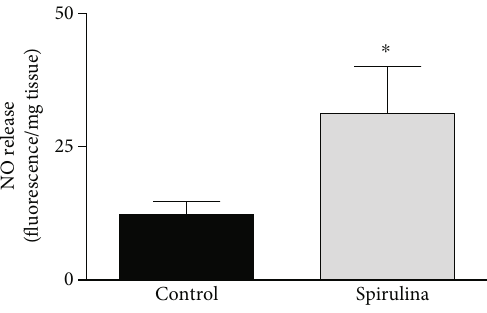
Figure 4: E ff ect of the aqueous Spirulina extract incubation on the basal release of NO in aortic segments from SHR. Results ( means ± SEM ) are expressed as arbitrary units of fl uorescence (AU) per milligram of tissue. Number of animals: 5-7. ∗ p < 0 : 05 compared with the control condition (in the absence of Spirulina